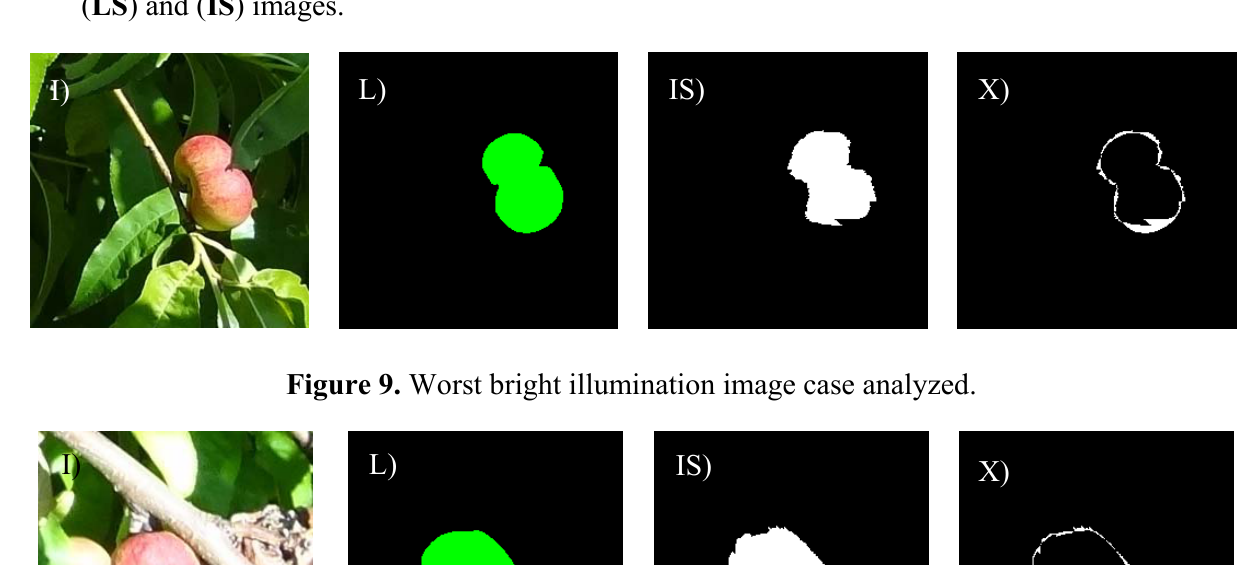
Figure 8. Example peach image results with bright illumination: ( I ) original image, ( L ) manually-labeled fruit, ( IS ) automatic segmentation, and ( X ) pixel differences between ( LS ) and ( IS ) images.